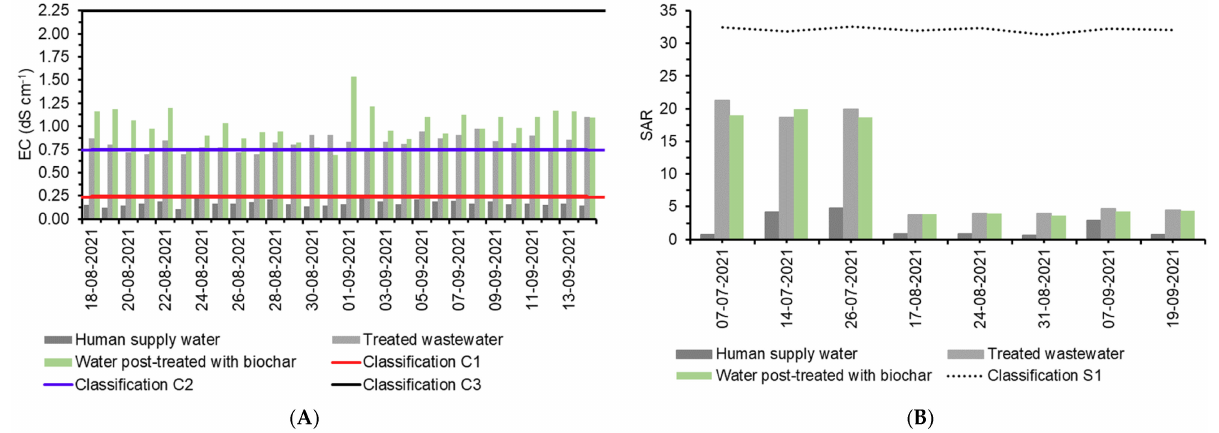
Figure 5. Values of water sources and limits for the risk of soil salinization and sodification: ( A ) electrical conductivity (EC) and ( B ) sodium adsorption ratio